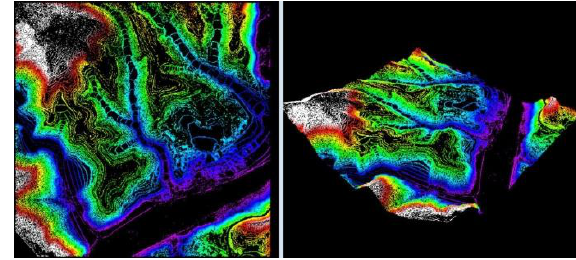
Figure 4. LiDAR overview.